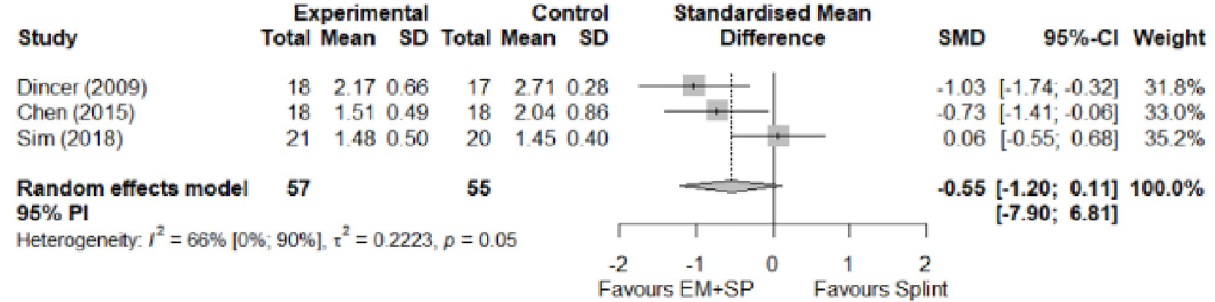
Fig 30. Analysis—Electrophysical modalities versus splinting (functional status).